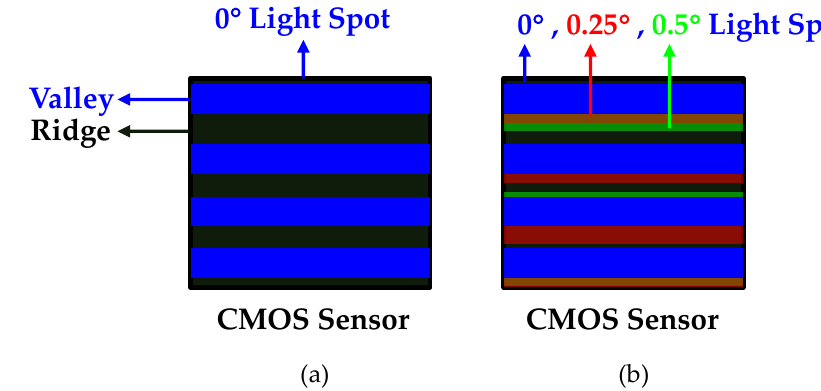
Figure 5. (a) Schematic diagram of light transmission area when propagating in the z direction. The blue box shows the range that the CMOS sensor can receive. (b) When the light is transmitted in the Z direction, the light spots at each angle gradually becomes separate from the transmission distance.